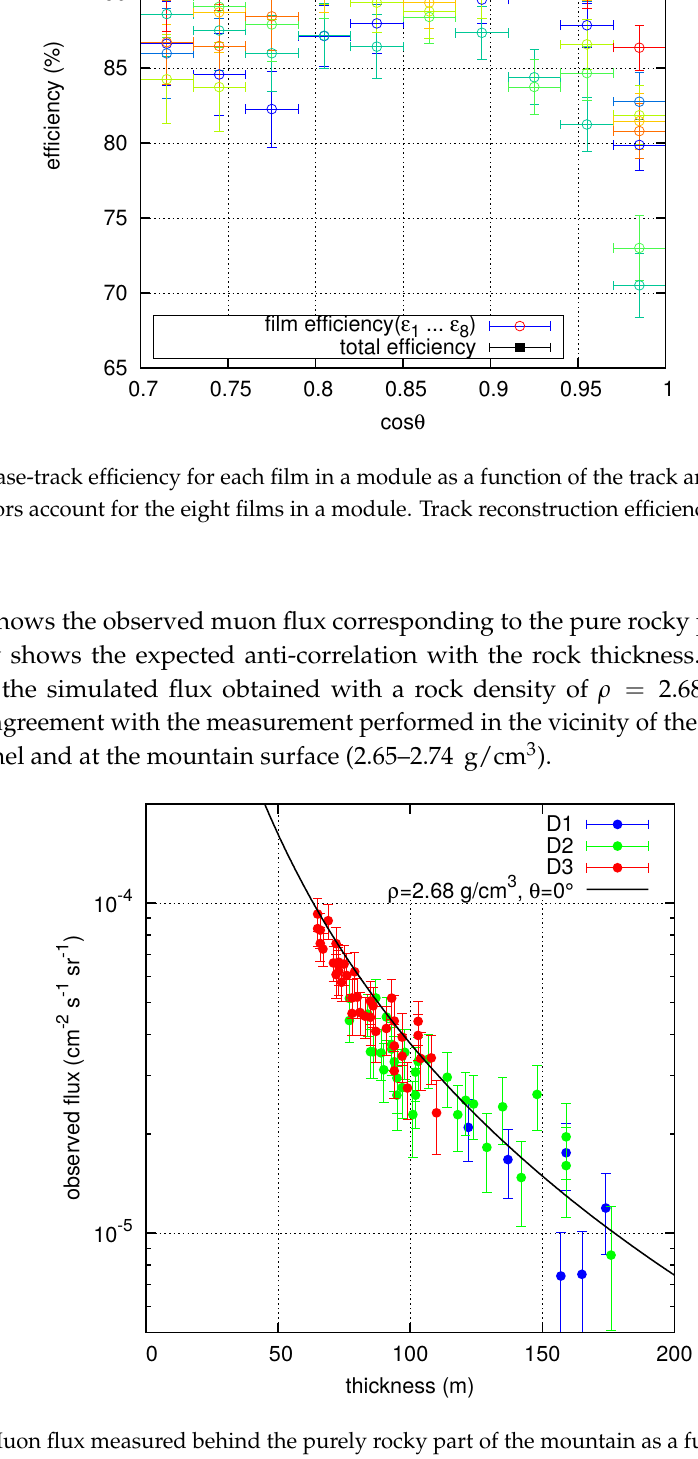
Figure 14. Muon flux measured behind the purely rocky part of the mountain as a function of the rock thickness (D1: blue, D2: green, D3: red). The theoretical attenuation for a rock density of 2.68g/cm 3 and zenith angle θ = 0 ◦ is displayed as a solid